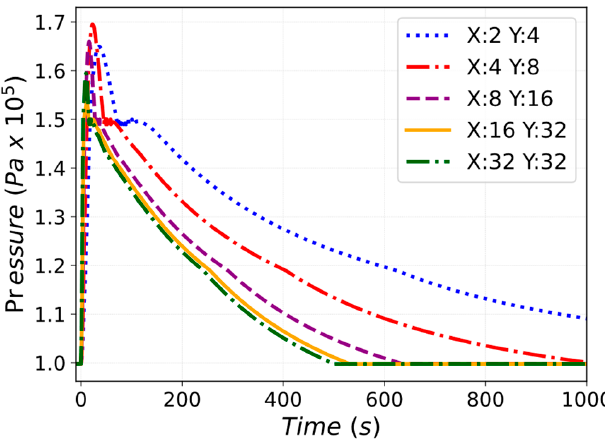
Figure 18. Pressure in the UPC for different numbers of relief